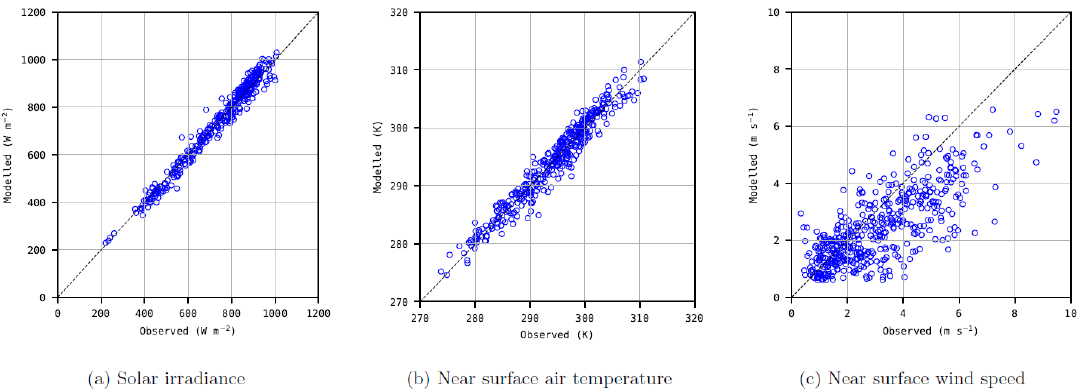
Figure 3. Scatterplot between the input ERA5 ensemble meant reanalysis data and in situ measurements for the main atmospheric forcings. Data from all validation sites is shown on the same plot.